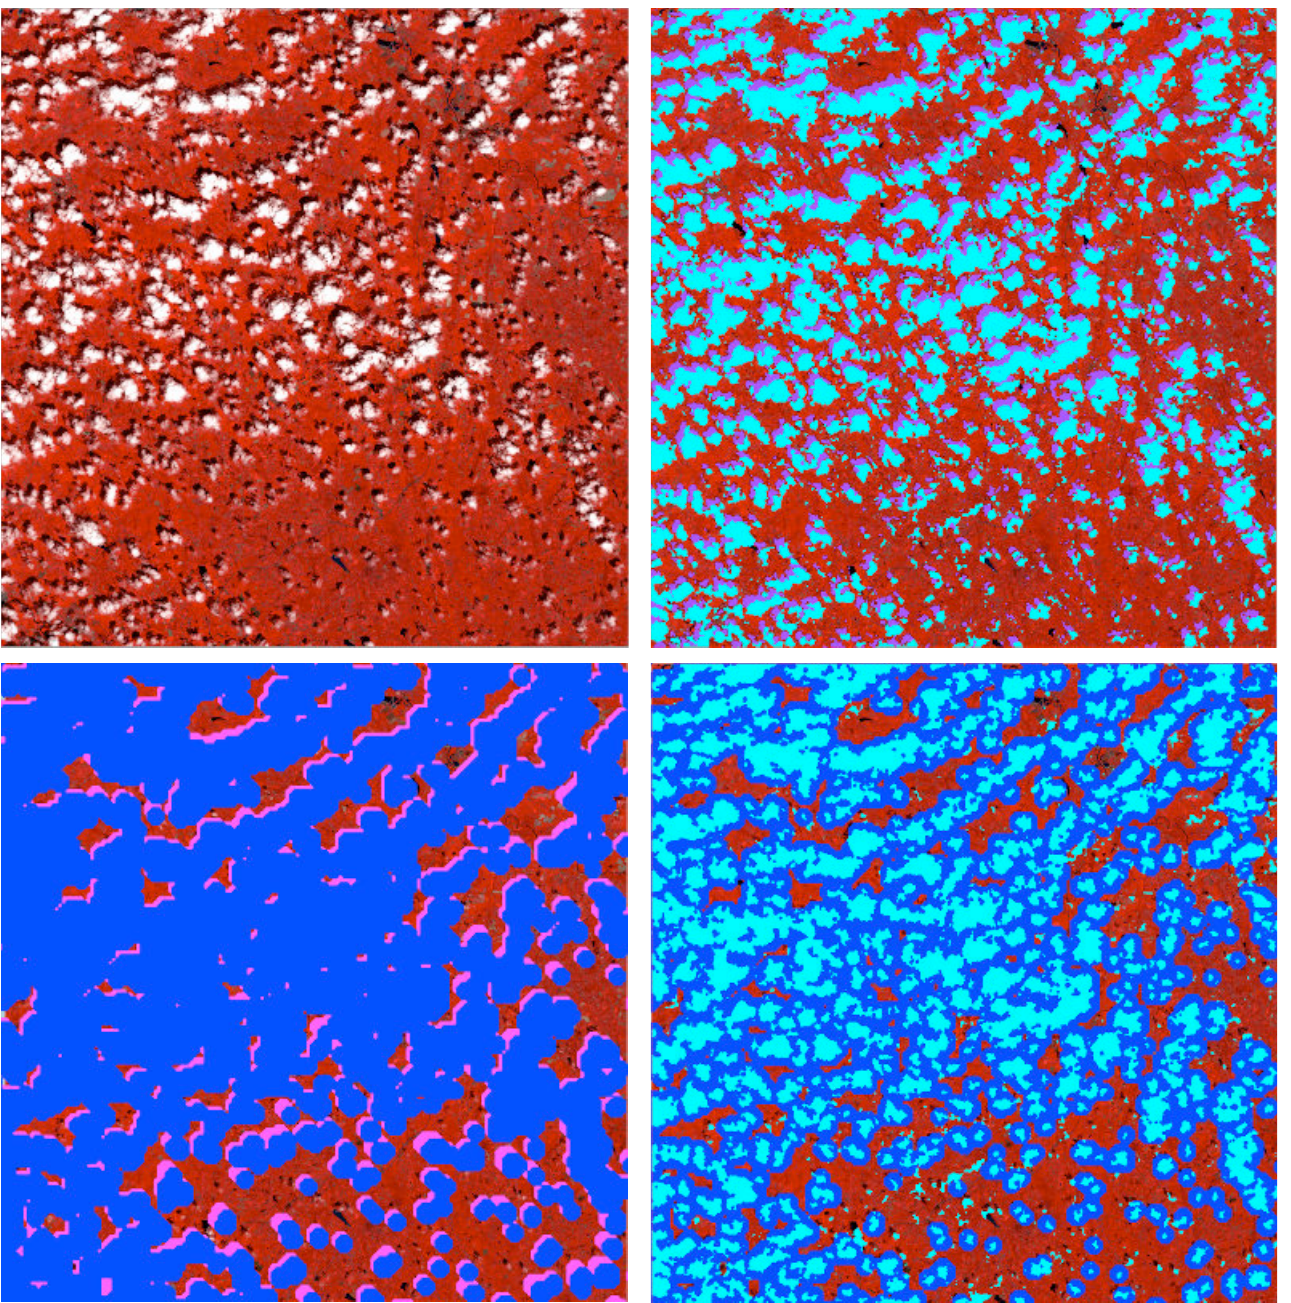
Figure 6. (top left) Initial Landsat 8 image, depicted here in a CIR mode. (top right) the outcomes of our method; in cyan, the detection of clouds and in violet, the detection of shadows. (bottom left) The existing cloud mask (in blue) and shadow mask (in purple), provided with input Landsat 8 images and computed using the MACCS software. (bottom right) The existing cloud mask (in blue), superimposed on our cloud mask (in